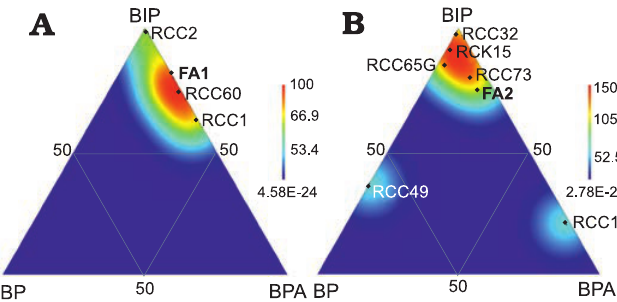
Fig. 7. Density maps in ternary diagrams showing percentages of bra- chiopod biovolume for the three different ecological groups (seminfaunal productides; pedicle-attached rhynchonellides, spiriferides, and terebratu- lides; pedicle-attached/free-living orthotetides, orthides, spiriferides, and spiriferinides with adaptation to softgrounds), calculated for FA1 ( A ), FA2 ( B ) and some collected assemblages with more than 20 specimens from FA1 ( A ) and FA2 ( B ) (see Table 2). Diagrams plotted with PAST software (Hammer et al. 2001). Abbreviations: BIP, biovolume of seminfaunal pro- ductides; BP, biovolume of pedicle attached rhynchonellides, spiriferides, and terebratulides (low to high efficiency); BPA, biovolume of pedicle at- tached/free living orthotetides, orthides, spiriferides, spiriferinides (low to high